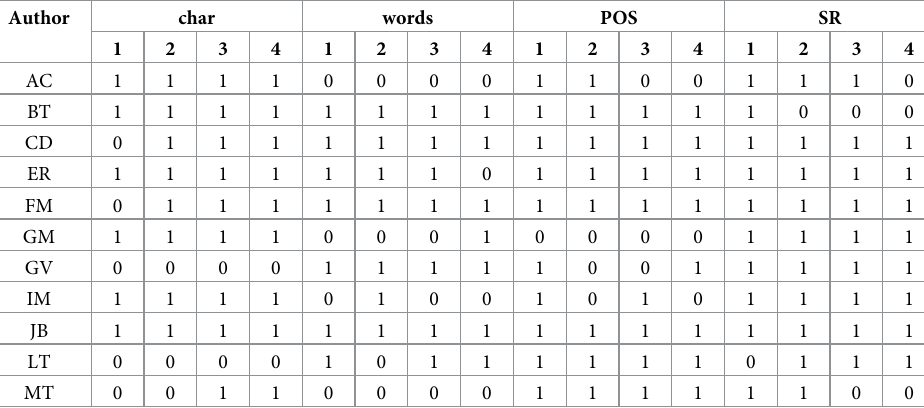
Table 14. One-sample T-test results for different types of 3-grams.